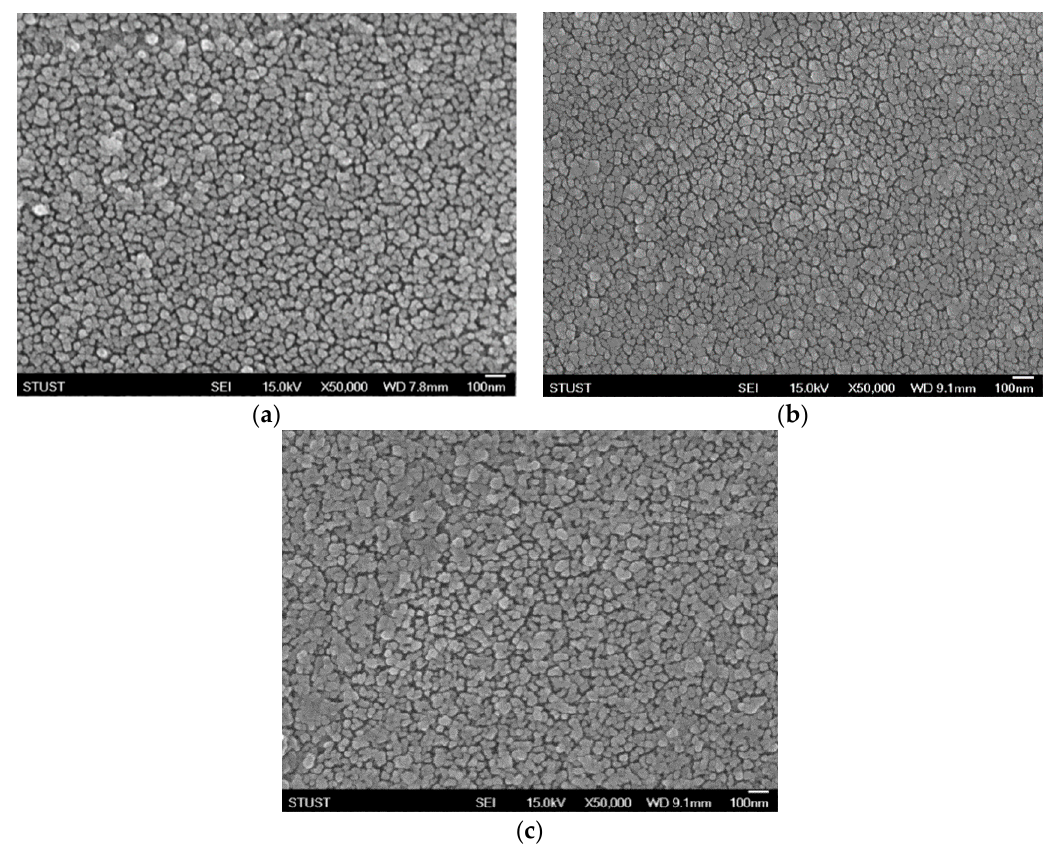
Figure 1. Scanning electron micrographs of the H 2 /N 2 plasma processed aluminum-doped zinc oxide (AZO)/tin-doped indium oxide (ITO) films at gas ratios of ( a ) 100/0, ( b ) 100/50, and ( c ) 100/100. X-ray di ff ractometer patterns of S1, S2, and S3 are presented in Figure 2, in which two peaks corresponding to the (002) of ZnO and the (222) of ITO may be observed. The peak with respect to (002) of ZnO is seen to slightly shift to a higher angle and its full width at half maximum (FWHM) decreases with increasing N 2